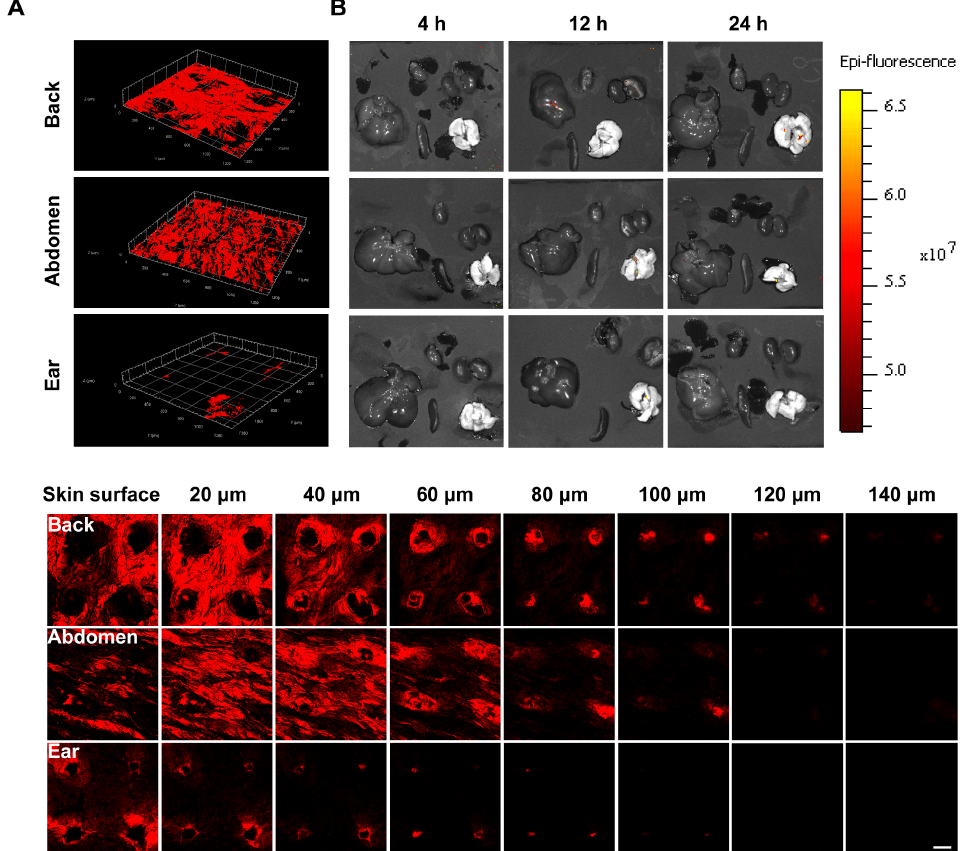
Figure 5. Ex vivo imaging. ( A ) Representative CLSM 3D reconstruction images (up) and 2D fluorescent images (down) of the skin of the back, abdomen, and ear of rats after being treated with P4 SLNs@DMNs at 4 h (scale bar: 100 μ m). ( B ) Representative fluorescent images of major organs after being treated with P4 SLNs@DMNs at 4, 12, and 24 h.